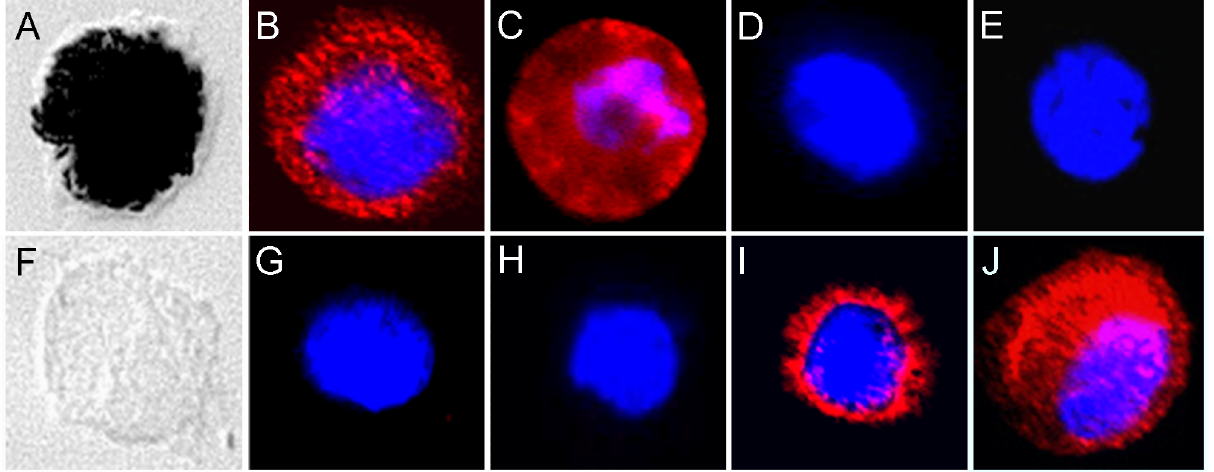
Figure 4. Immunocytochemistry of equine RPE cells. Upper panel ( A – E ) shows native equine RPE cells. Lower panel ( F – J ) shows cultured equine RPE cells of passage-4. Native cells show positive immunoreactivity for CRALBP ( B ) and RPE65 ( C ). Native cells show no immunoreactivity for fibronectin ( D ) and CD49c ( E ). In passage-4 RPE cells, CRALBP ( G ) and RPE65 ( H ) do not show immunoreactivity, other than fibronectin ( I ) and CD49c ( J ), which is found positive in passage-4 cells. Nuclei were stained with 4'6-diamidino-2-phenylindole (DAPI). A and F show Nomarski imaging of the respective RPE cells, native ( A ) and passage-4 ( F